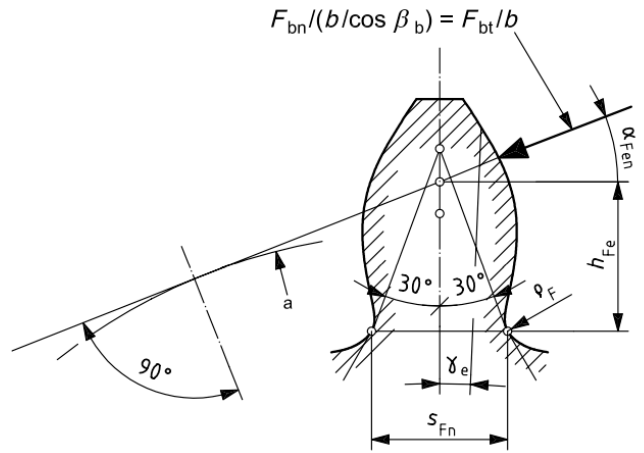
Figure 1. Determination of normal chordal dimensions of tooth root critical section according to ISO 6336-3:2019—Method B.